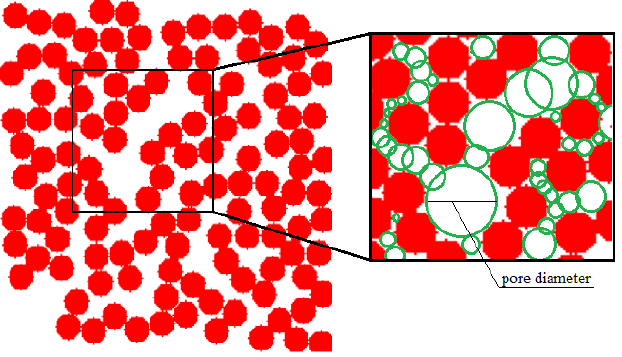
Figure 8. Cross-section of generated structure 13 with placed pores (green circles).